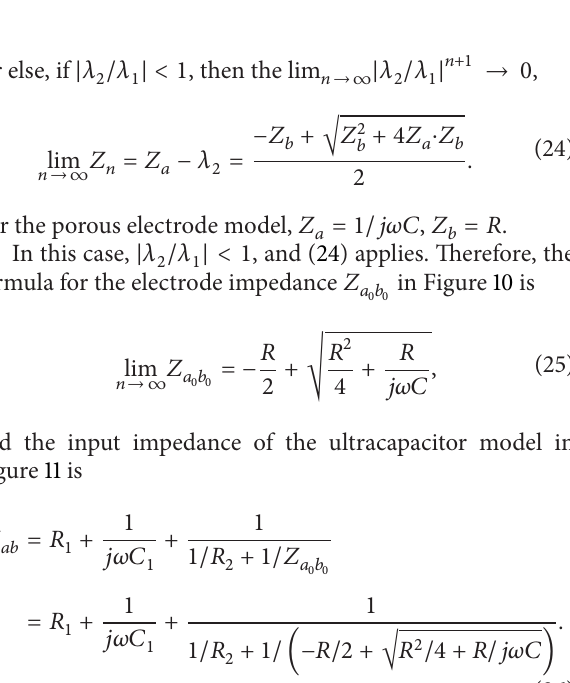
Figure 14: The Comparison between measured numbers and calculated numbers in Nyquist